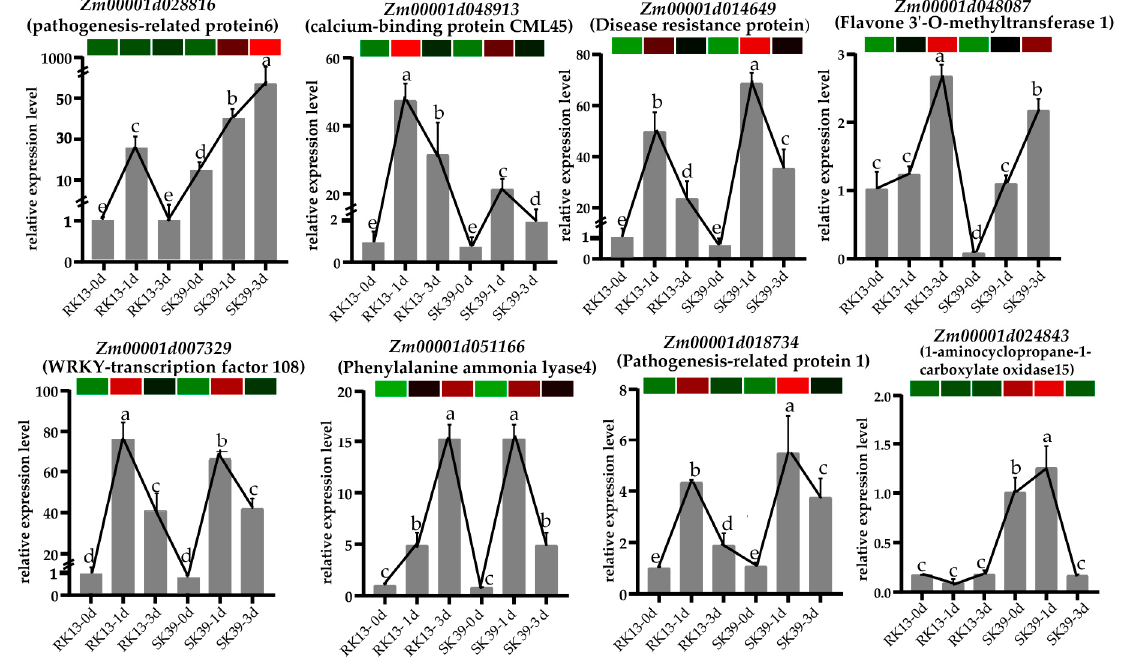
Figure 7. qRT-PCR validation of DEGs at different time points (0 dpi, 1 dpi and 3 dpi). Heatmaps are based on FPKM of transcriptome data. Lines represented gene expression changes in different samples. Values followed by different lowercase letters are significantly different at p < 0.05, and the error line is the standard error.